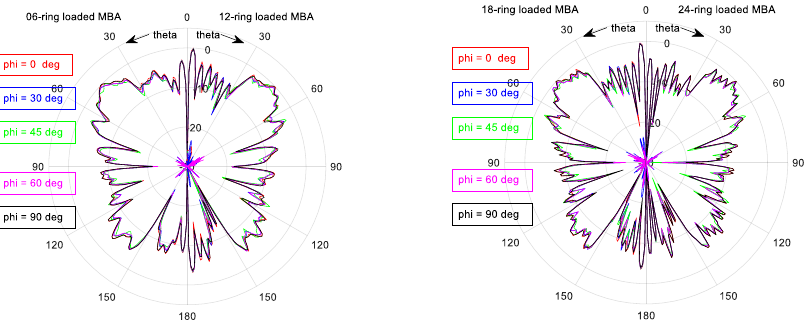
Figure A10. 2D patterns at 57 GHz of 6-, 12-, 18- and 24-ring-loaded MBA in different cutting planes.